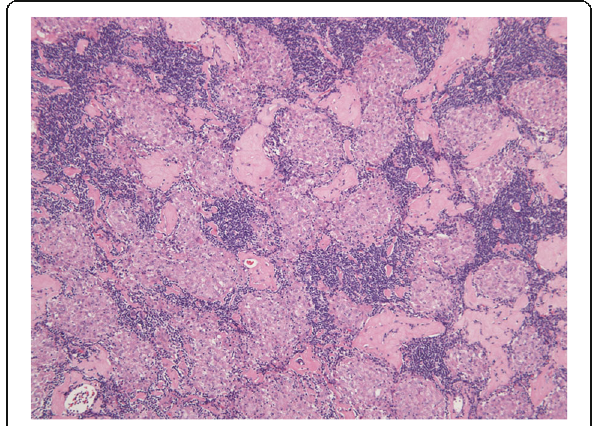
Fig. 4 Histology of lymph nodes resected from case 2. A photomicrograph of the specimen shows granulomatous reactions containing several small epithelioid cell granulomas without malignant cells (magnification ×100, Hematoxylin and Eosin staining)